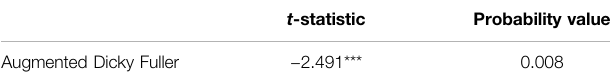
TABLE 6 | Results from the Kao Panel Co-integration test.